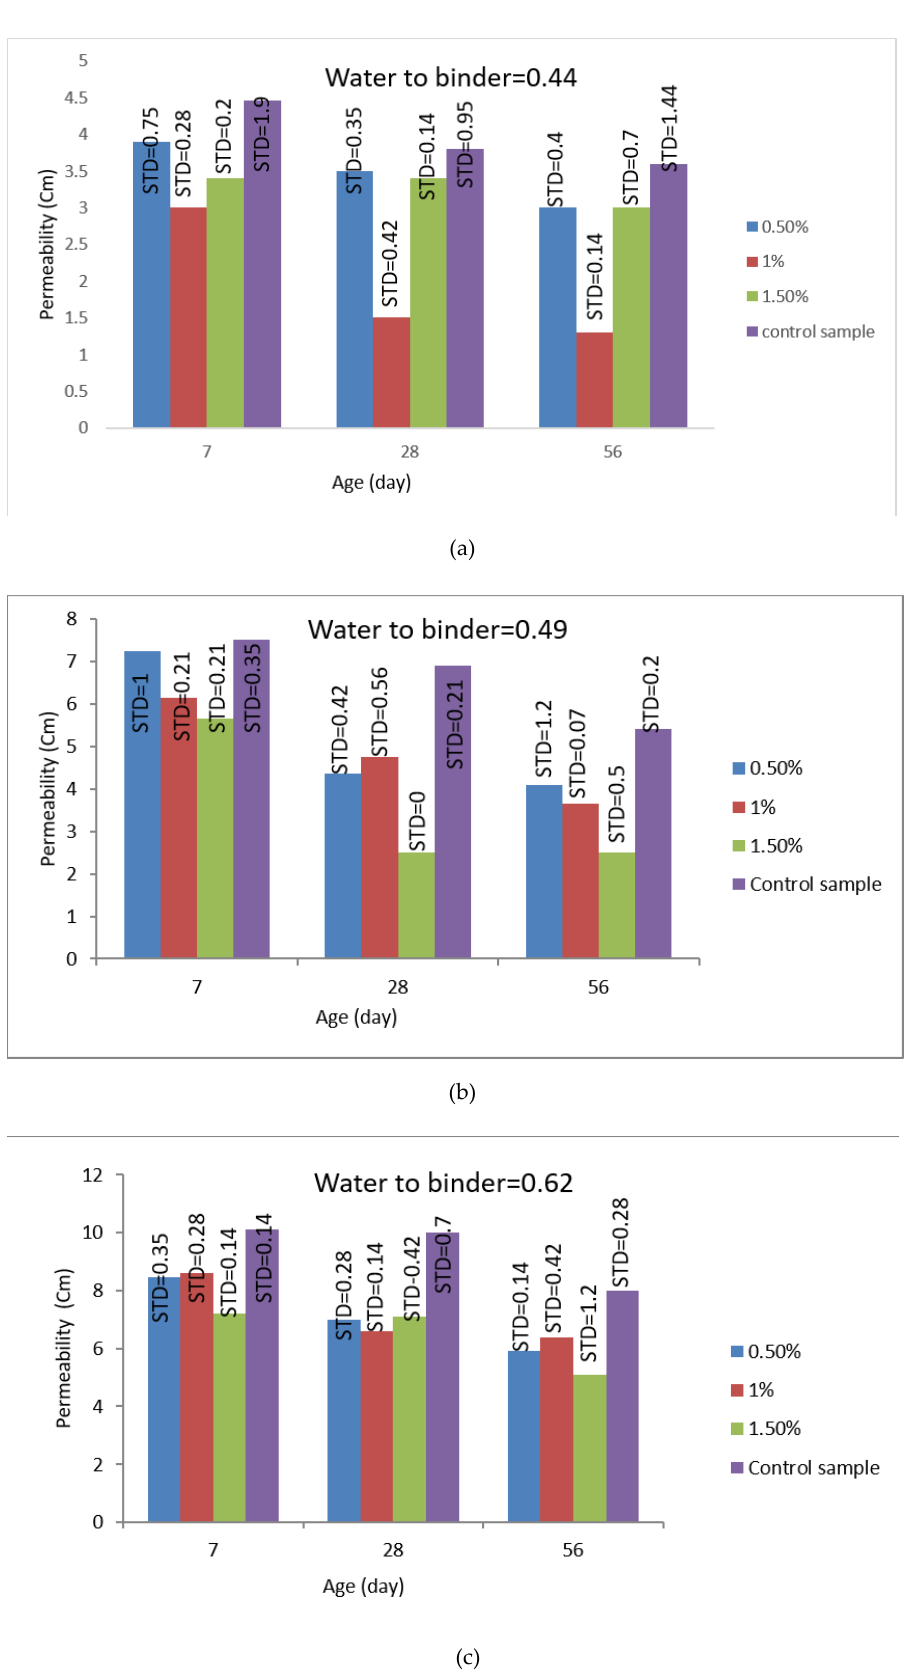
Figure 10. Permeability vs. age for water-to-binder ratios of ( a ) 0.44, ( b ) 0.49, and ( c )